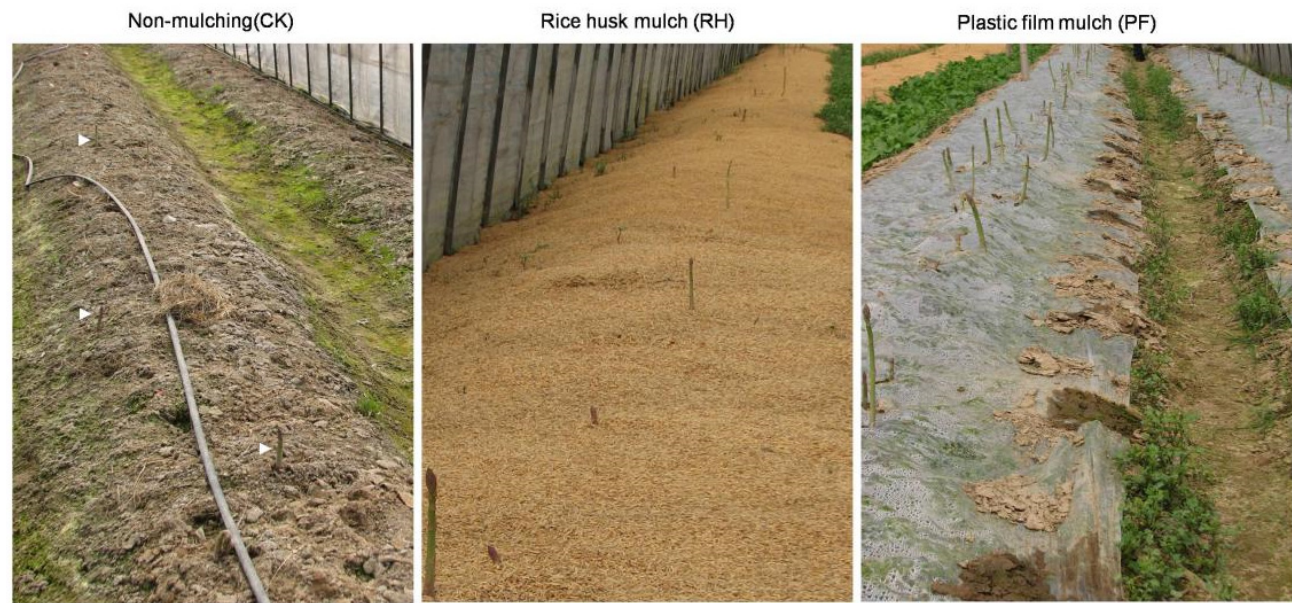
Figure 1. Experiments on non-mulching treatment (CK), rice-husk mulch (RH), and plastic film mulch (PF) of green asparagus in the plastic tunnel.